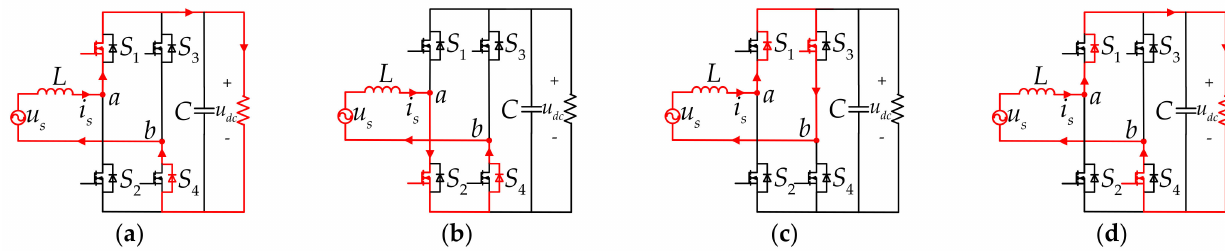
Figure 7. The current path during the dead-time when i s > 0. ( a ) (1,0,0,0); ( b ) (0,1,0,0); ( c ) (0,0,1,0); ( d ) (0,0,0,1).